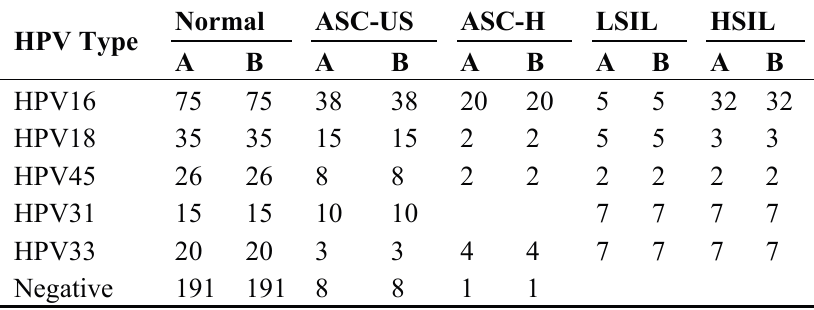
Table 3. Comparison of the results of HPV genotyping by the sequencing analysis and HPV genotyping 9G membrane test in the 550 clinical